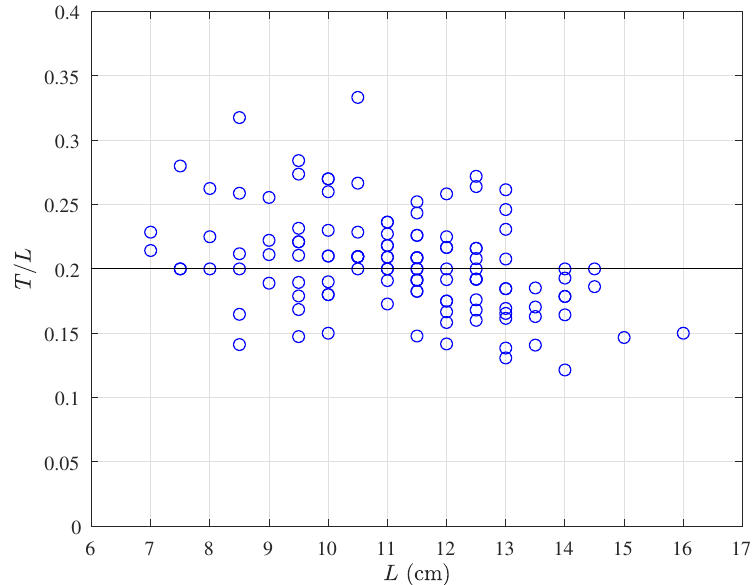
Figure 6. Measured thickness of Asterias rubens as a function of length. The solid line corresponds to (11).